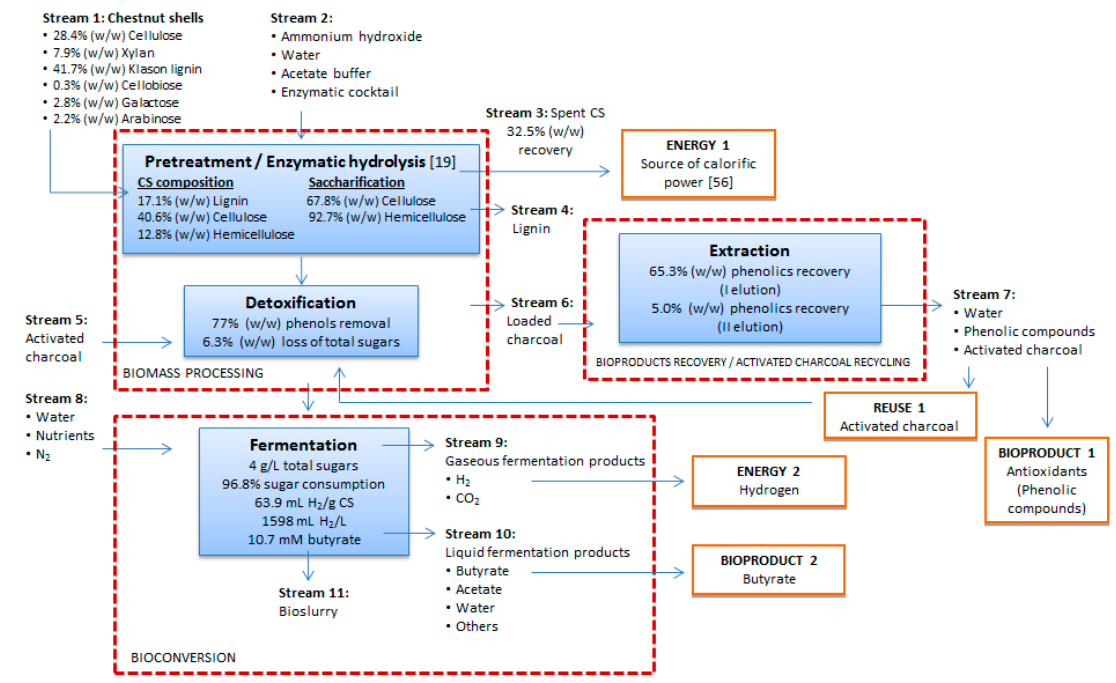
Figure 3. Chestnut shells biorefinery model.